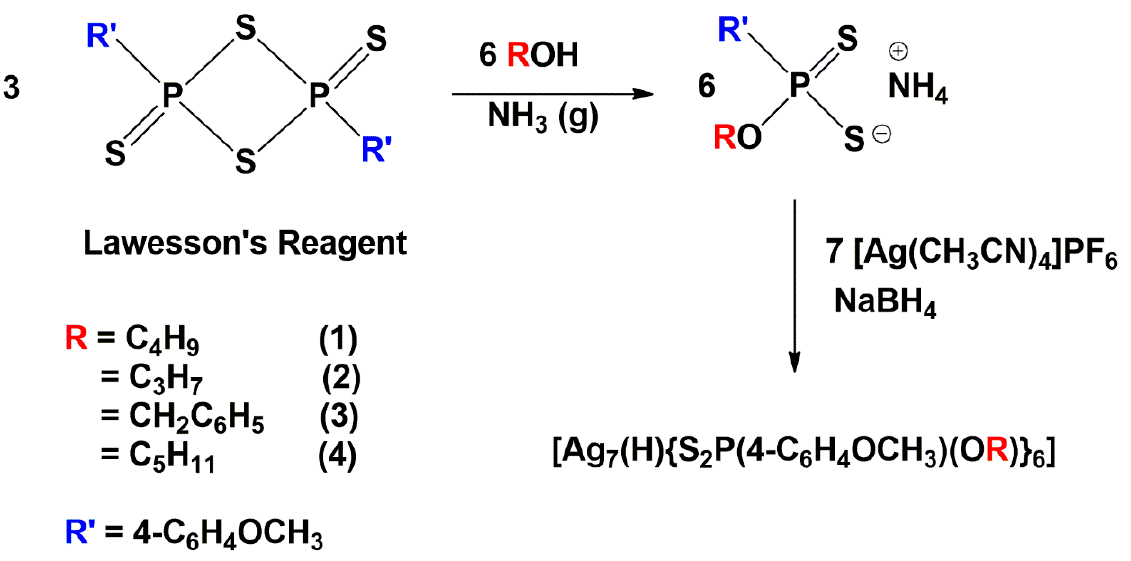
Scheme 1. The reaction scheme for the synthesis of the silver monohydride